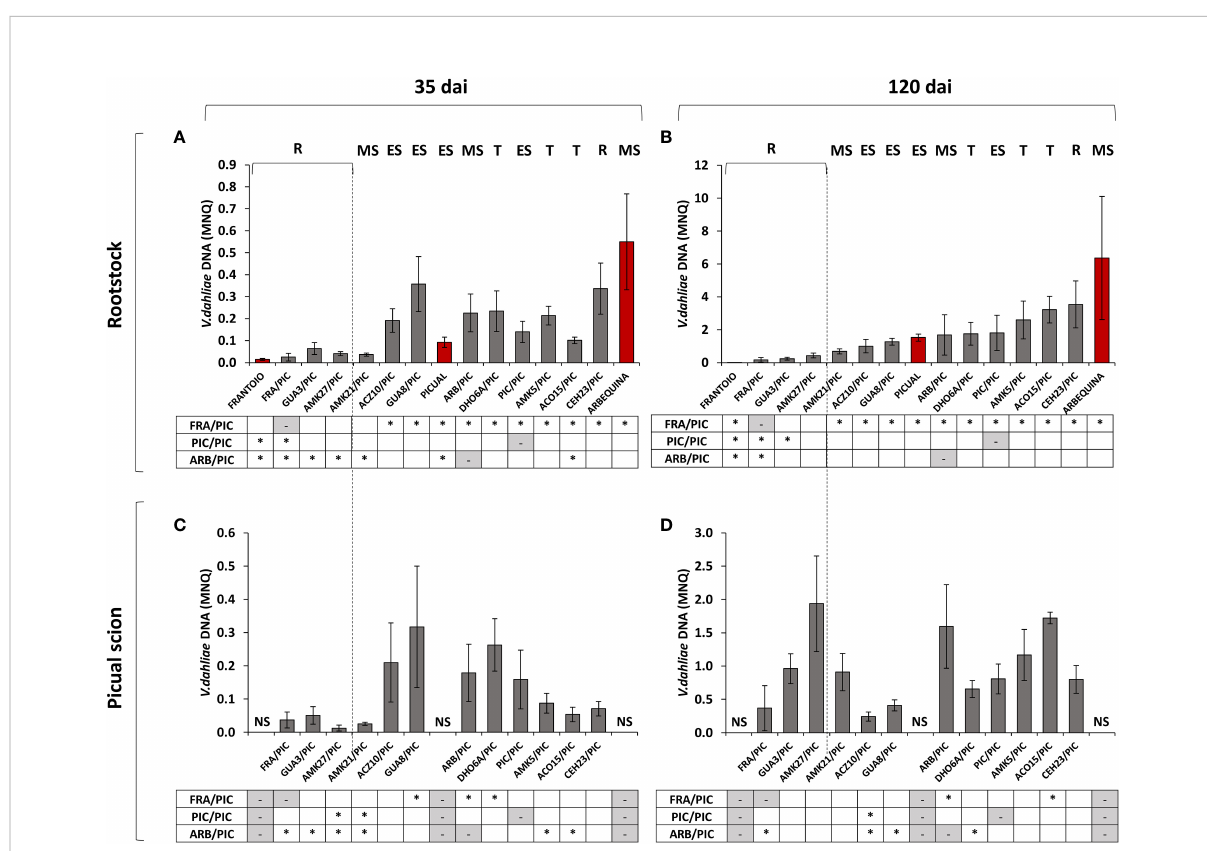
FIGURE 4 Mean Normalized Quantity (MNQ) of Verticillium dahliae DNA in the stem of grafted olive rootstocks evaluated at 35 days after inoculation (dai) with the defoliating isolate VD117 (A) and at 120 dai (B) . MNQ of V. dahliae DNA in the ‘ Picual ’ grafted scion evaluated at 35 dai (C) and at 120 dai (D) . Red bars represent non-grafted ‘ Frantoio ’ , ‘ Arbequina ’ , and ‘ Picual ’ plants as reference cultivars of resistant, moderately susceptible, and extremely susceptible genotypes, respectively. Asterisks indicate signi fi cant differences with the DNA values of ‘ Picual ’ grafted onto ‘ Frantoio ’ (FRA/PIC), ‘ Arbequina ’ (ARB/PIC), and ‘ Picual ’ (PIC/PIC) plants, respectively. NS means No Scion in non-grafted plants. Results are the mean of 16 plants per genotype and error bars correspond to the standard